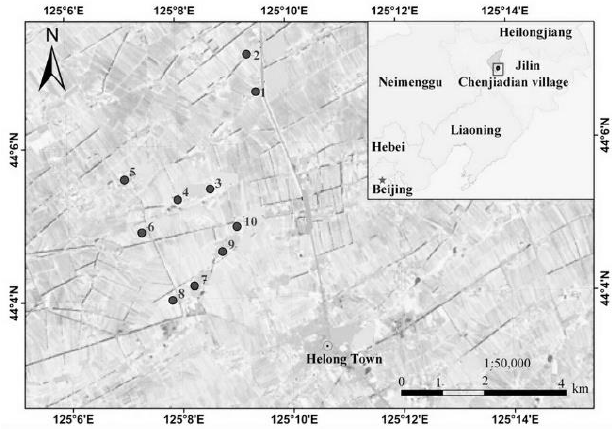
Figure 2. The location of Chenjiadian and the distribution of the ten natural villages.